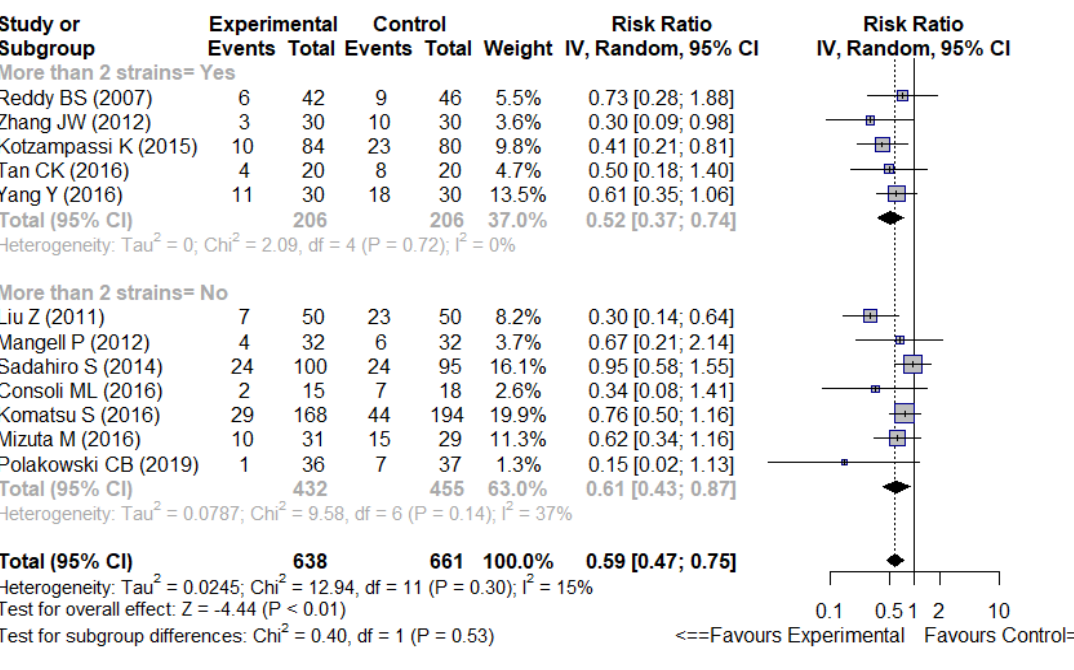
Figure 5. Forest plot of multistrains [7,24,28,32,36] versus non-multistrains [26,27,31,33–35,40] probiotic or synbiotic. Outcome = overall infectious complications.